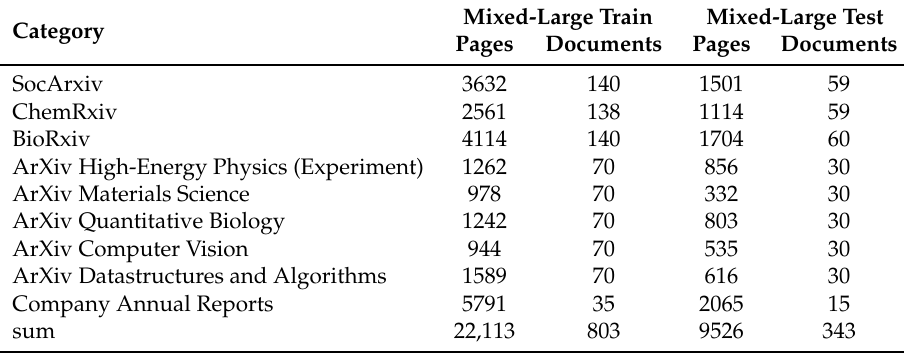
Table 1. Composition of the corpus. We split the corpus up into canonical training and test sets document-wise because some documents contain several very similar figures and table styles. These portions of the corpus are referred to as Mixed-Large-Train and Mixed-Large-Test